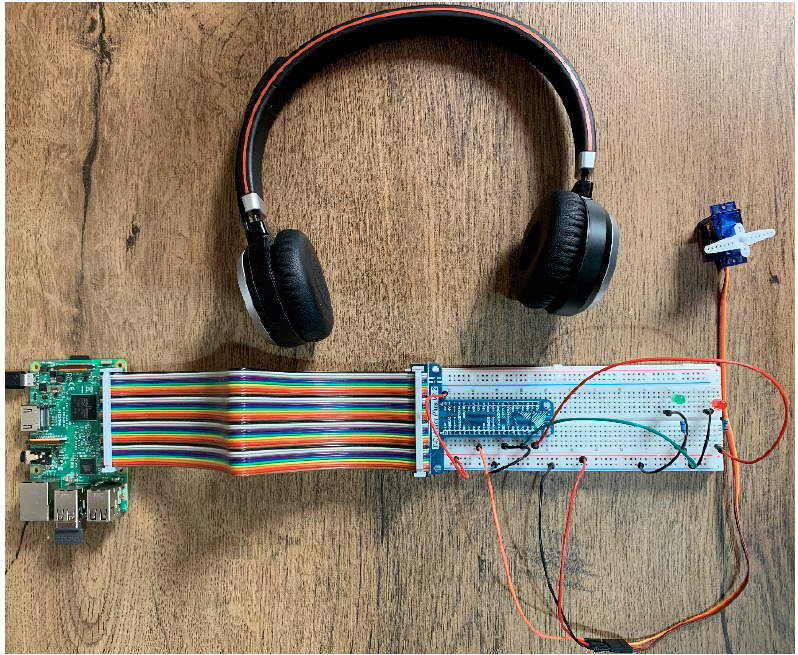
Figure 15. Real implementation of the voice control actuator using Bluetooth headphones for better comfort and freedom.